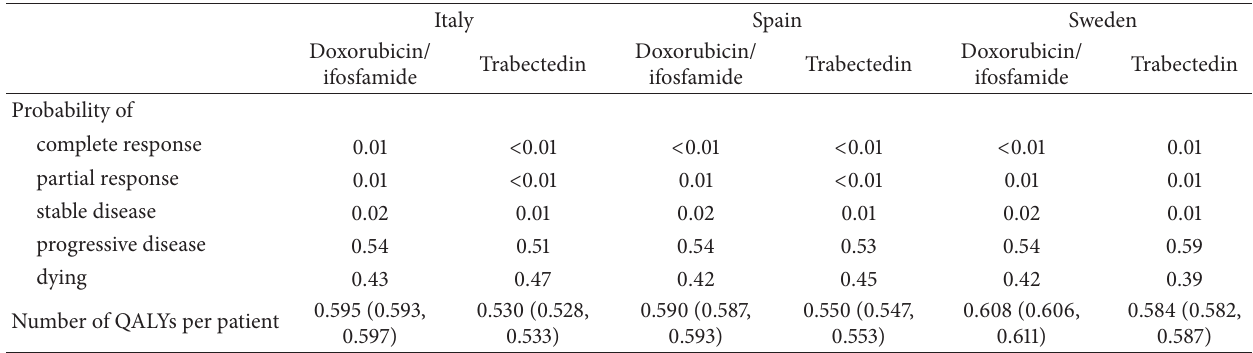
Table 6: Clinical outcomes at two